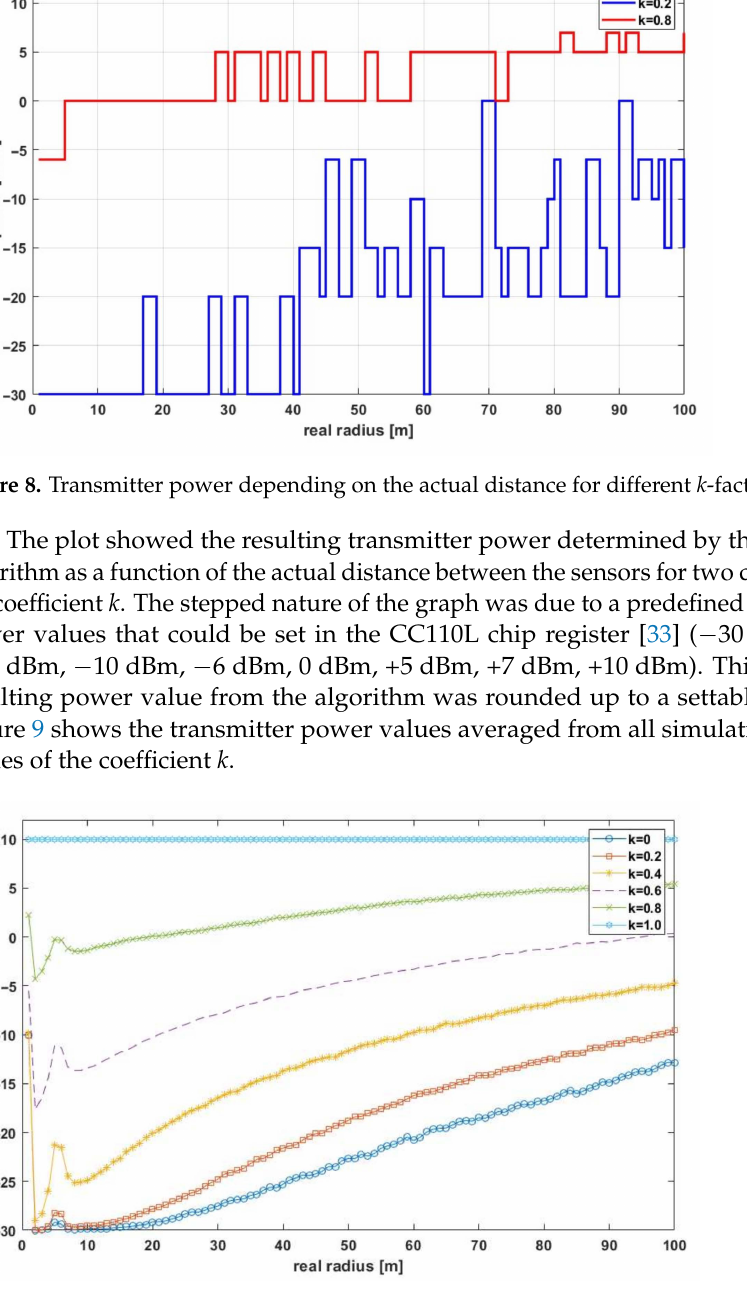
Figure 9. The average power of the transmitter for different values of the k -factor. It can be seen that for both short and long distances between the effector and the sensor, the difference in transmitter power for different k was roughly proportional. This means in simple terms that k TX ~ SINR RX . Because of this relationship, the effect of the k coefficient on localization accuracy using the RSSI method was analyzed [26]. Figure 10 shows the estimation results (as a set of points) of the effector-sensor distance for the running ATPC algorithm (Equation (10)) as a function of distance for different values of the k coefficient for AWGN channel interference described by a normal distribution with a constant mean of − 110 dBm